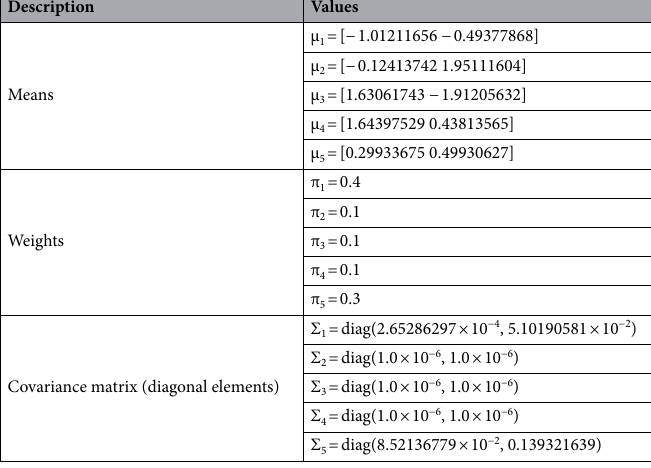
Table 3. GMM parameters for standardized 2 PCs in analysis for the fatty acid profile.